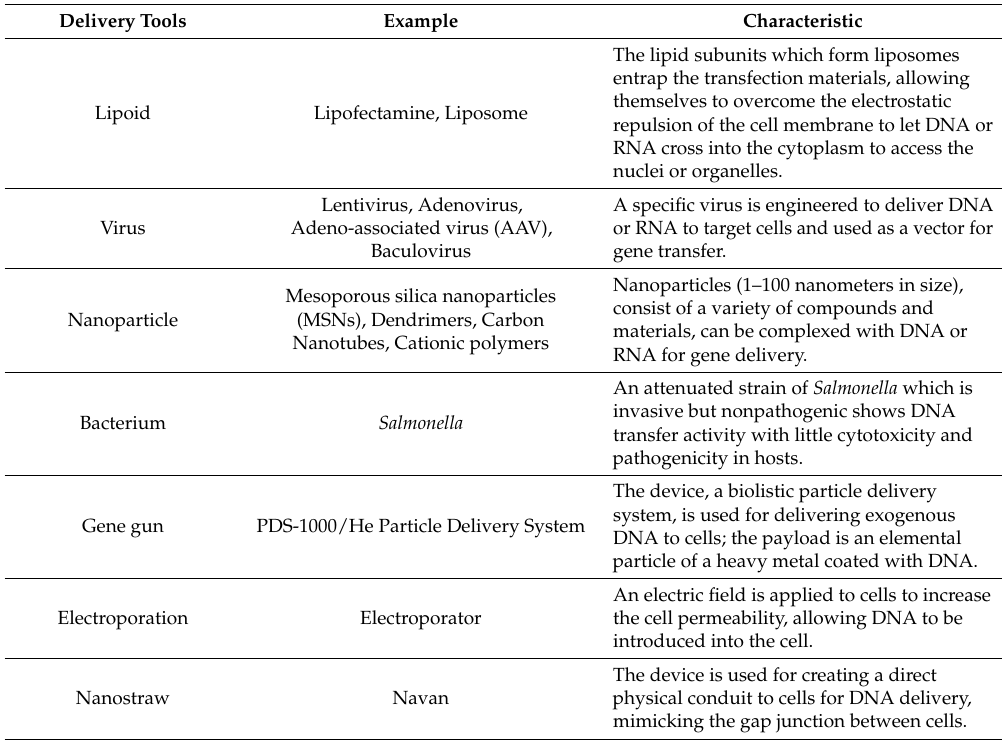
Table 2. Delivery tools for